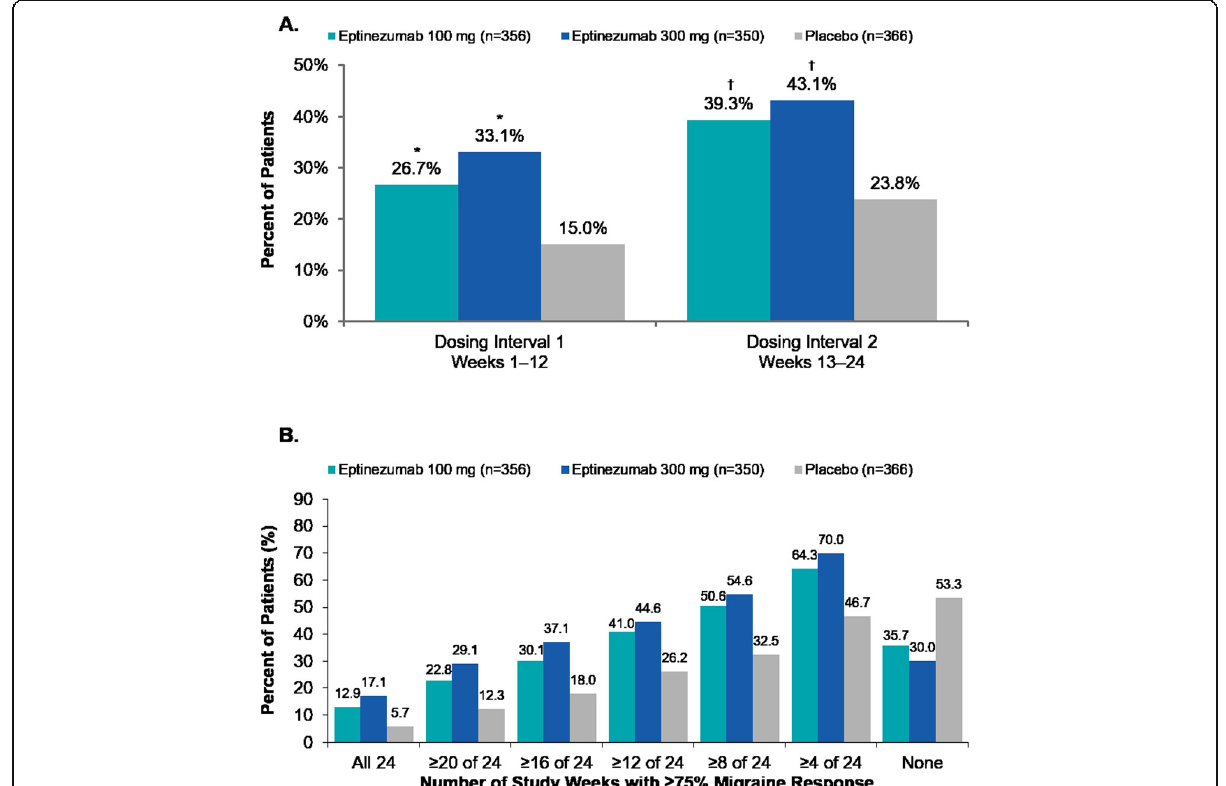
Fig. 4 ( a ) Rates of ≥ 75% migraine response by 12-week dosing interval and ( b ) cumulative 4-week intervals with ≥ 75% migraine response (efficacy population). *P ≤ 0.001 vs placebo